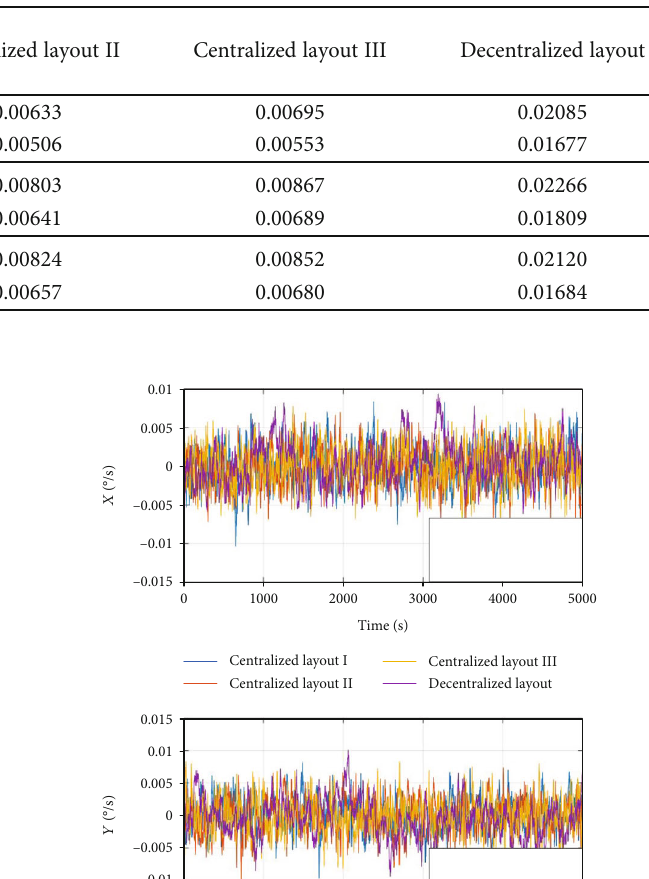
Table 2: RMSE and MAE of estimation error of Euler angles.